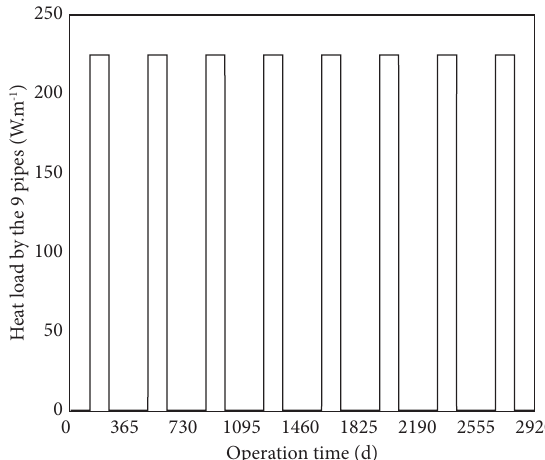
Figure 7: Total heat load for the 9 pipes during 5 years.